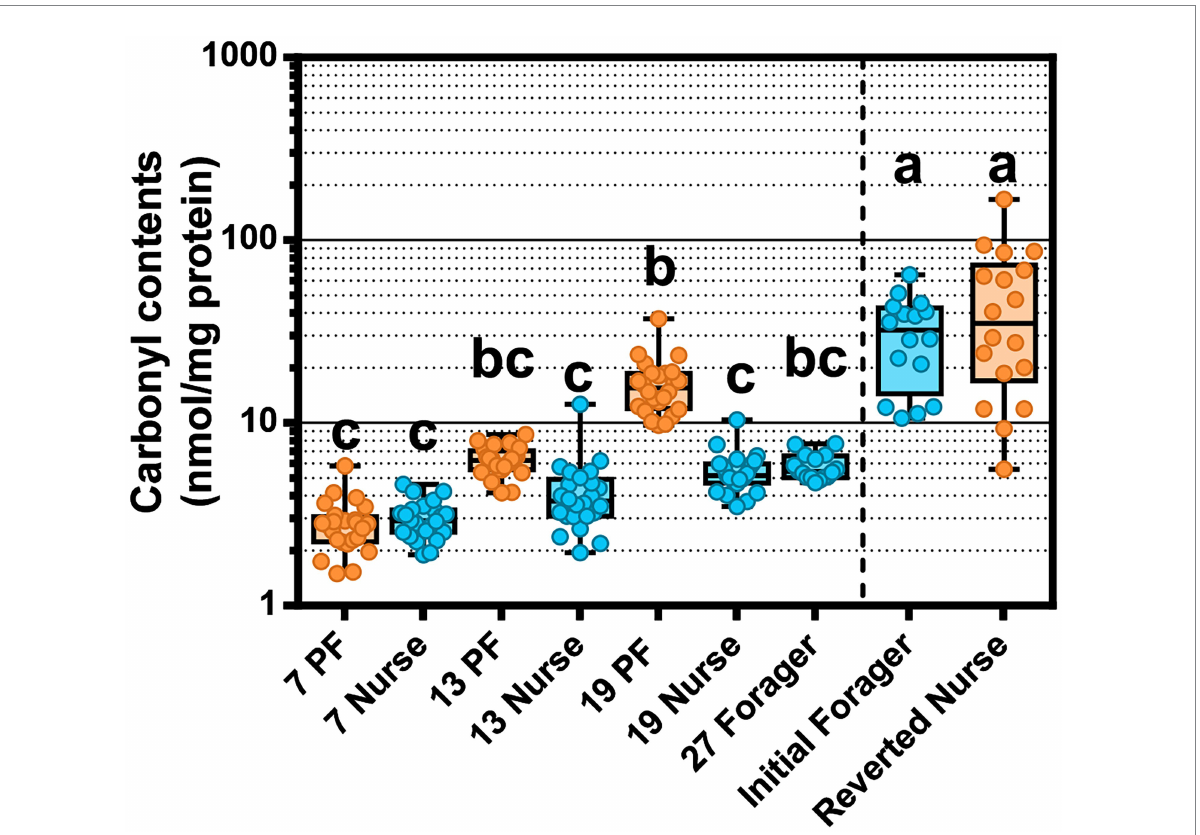
FIGURE 7 Oxidative stress measured as protein carbonylation in the worker fat body. Different letters indicate significant differences ( p < 0.05). The line separates PF and REV experiments. REV initial foragers and reverted nurses have unknown ages, but were presumed to be the oldest bees across both